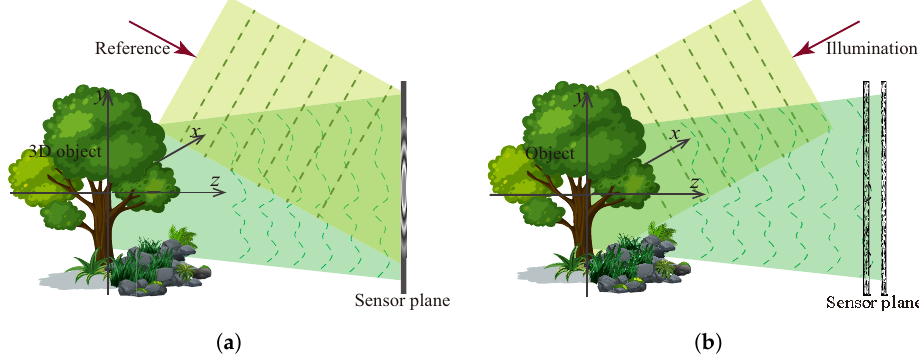
Figure 5. Two typical wavefront imaging techniques: interferometric ( a ) and phase imaging ( b